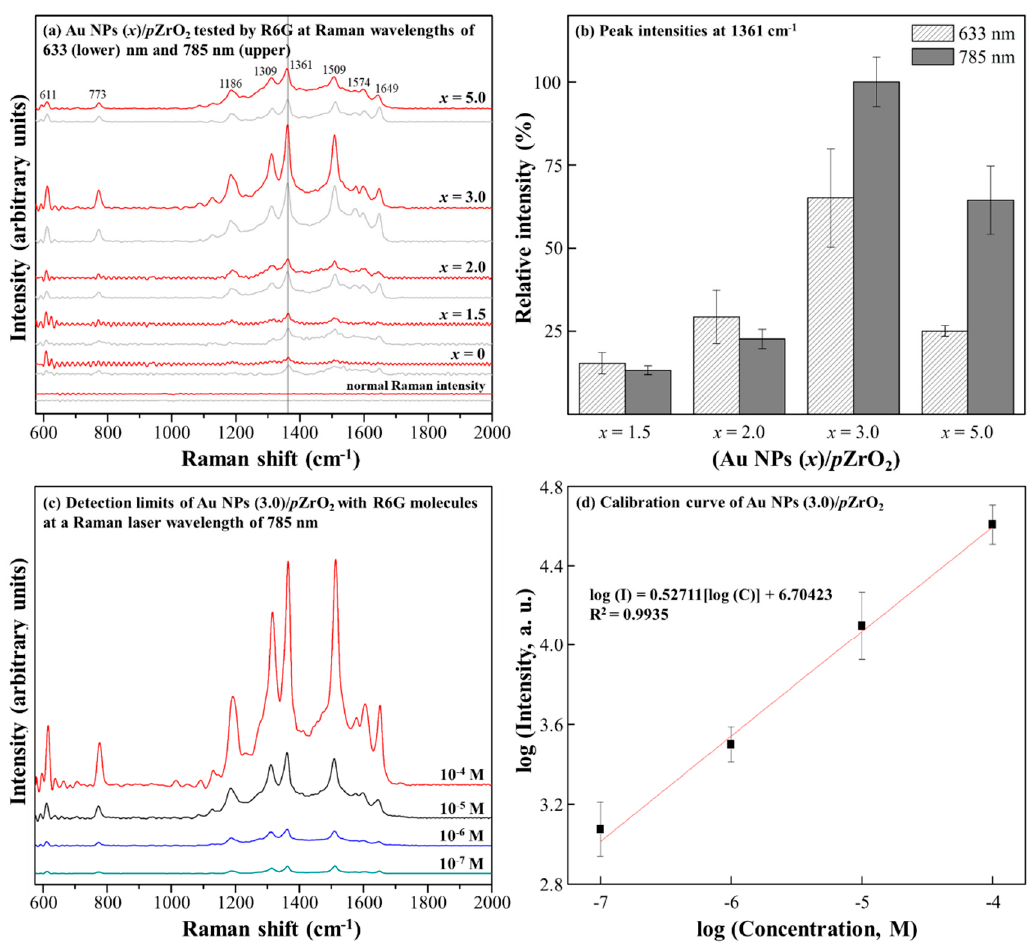
Figure 3. ( a ) SERS spectra of 10 − 3 M R6G measured at the respective excitation wavelengths of 633 and 785 nm on Au NPs / p ZrO 2 SERS substrates and normal Raman on plain Si; indicated as shown is the most intense peak which is at 1361 cm − 1 ; ( b ) Relative Raman intensities of 10 − 3 M R6G at the 1361 cm − 1 peak taken using the Au NPs ( x ) / p ZrO 2 samples at 633 and 785 nm excitation wavelengths show the e ff ects of varying the laser wavelengths and Au NP deposition thickness; ( c ) SERS spectra of varying concentrations of R6G on Au 3.0 / p ZrO 2 showing a relative decrease in the peak intensities with decreasing concentration; ( d ) Calibration plot produced by the logarithmic linear trend between the 1361 cm − 1 peak intensity and concentration.